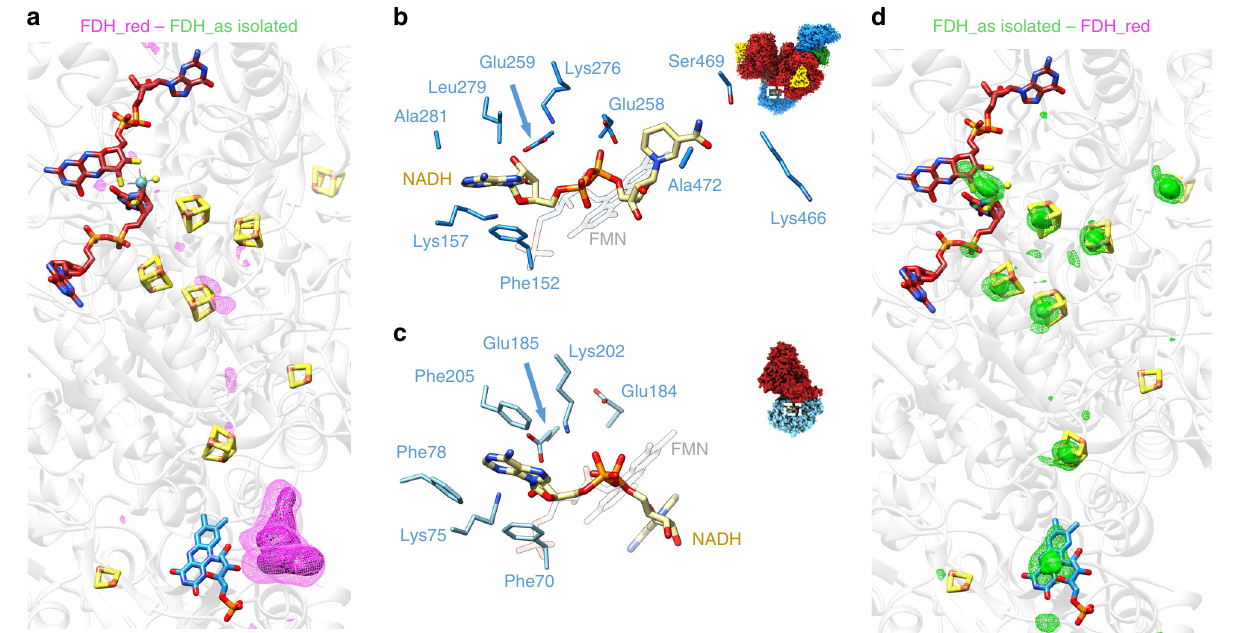
Fig. 4 The NADH-reduced structure of Rc FDH. a Surface representation of difference map (magenta mesh at 18 σ and 11 σ ) between the NADH reduced and the as isolated cryo-EM maps. The atomic model overlaid with the as isolated cryo-EM structure is shown as white ribbon with coloured cofactors. b Close-up of the NADH binding site in the NADH-reduced structure of Rc FDH. NADH interacting residues and the position of FMN are indicated c Close-up of the NADH binding site in Tt RCI (PDB-ID 3iam [https://doi.org/10.2210/pdb3IAM/pdb]). d Surface representation of difference map (green mesh at 18 σ and 11 σ ) between the as isolated and the NADH reduced cryo-EM